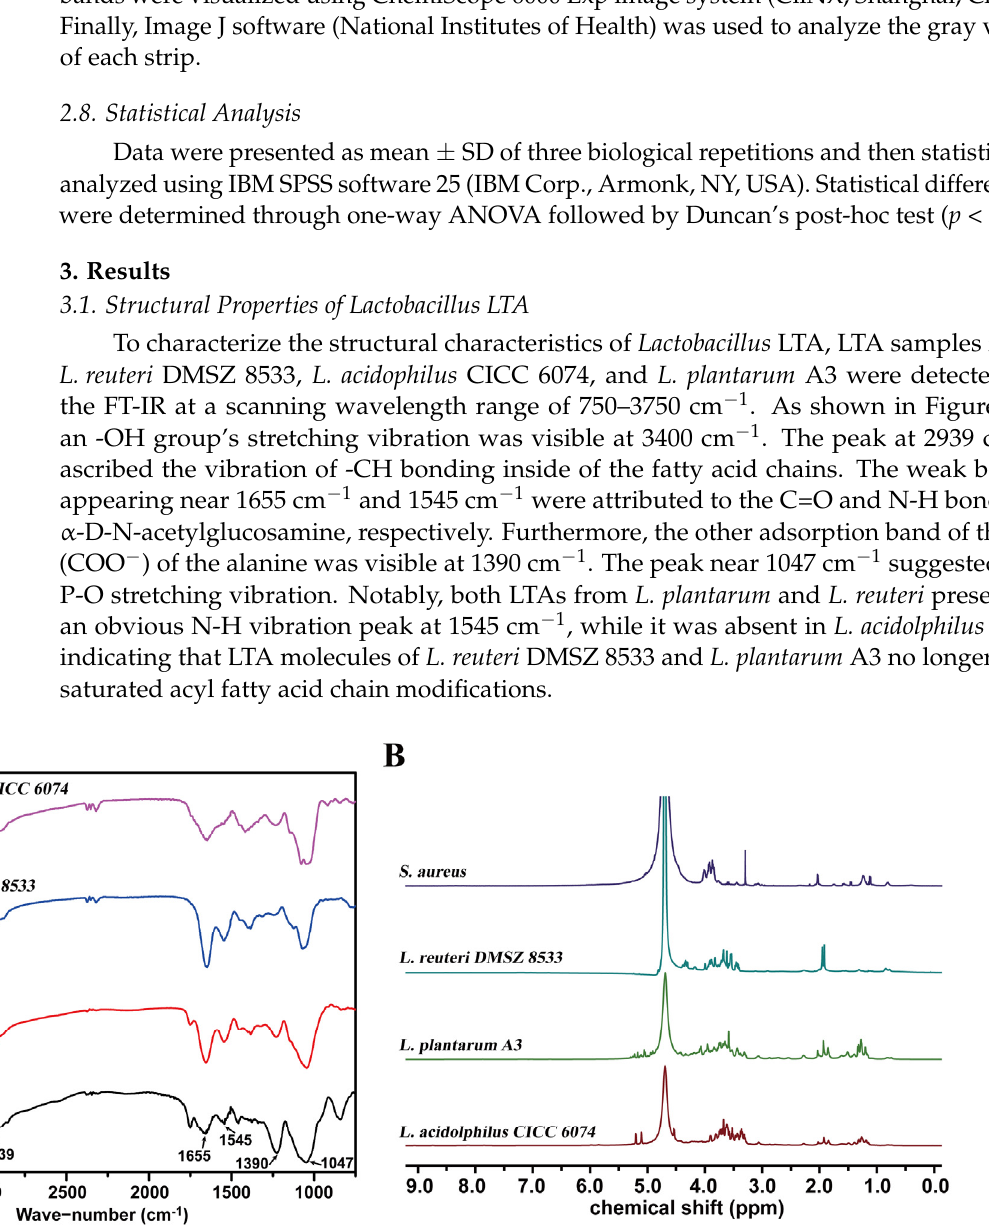
Figure 1. Multi − spectrometric analyses of the LTA structure in Lactobacillus strains. ( A ) The FT − IR spectra of LTA from Lactobacillus and LTA standard substance of S. aureus . ( B ) NMR spectra of intact LTAs. 1 H NMR spectra (500 MHz, 298 K) of intact LTAs from S. aureus and Lactobacillus in 2H 2 O.